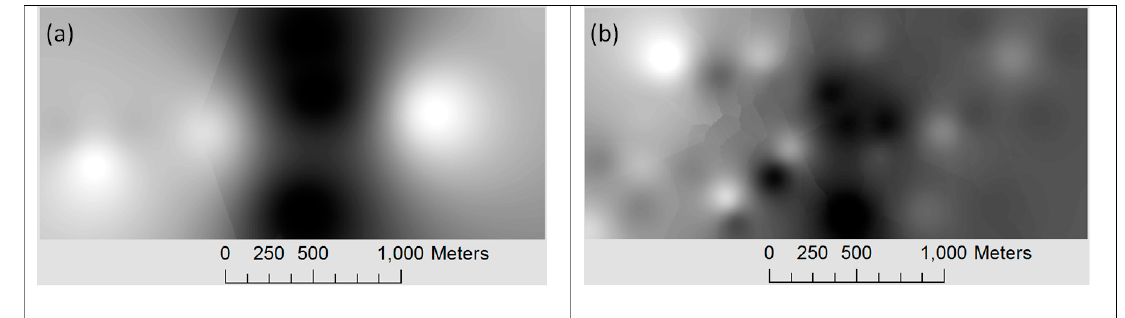
Figure 11. Raster layers that reflect people’s opinions in experiment 2 for ( a ) legibility; and ( b ) permeability. Both experiments are summarized by the parameter values derived (Figures 5 and 6) and the final values of legibility and permeability (Figure 7).